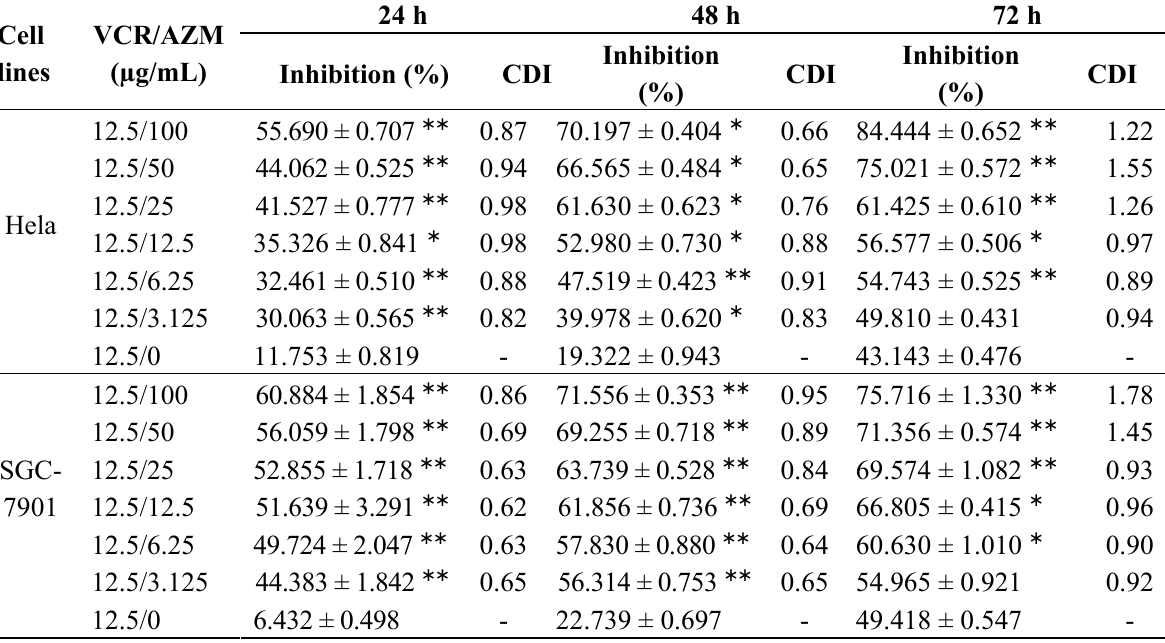
Table 1. Synergistic inhibition of VCR and AZM on cancer cell lines (%) (Mean ± SD) a . Cell